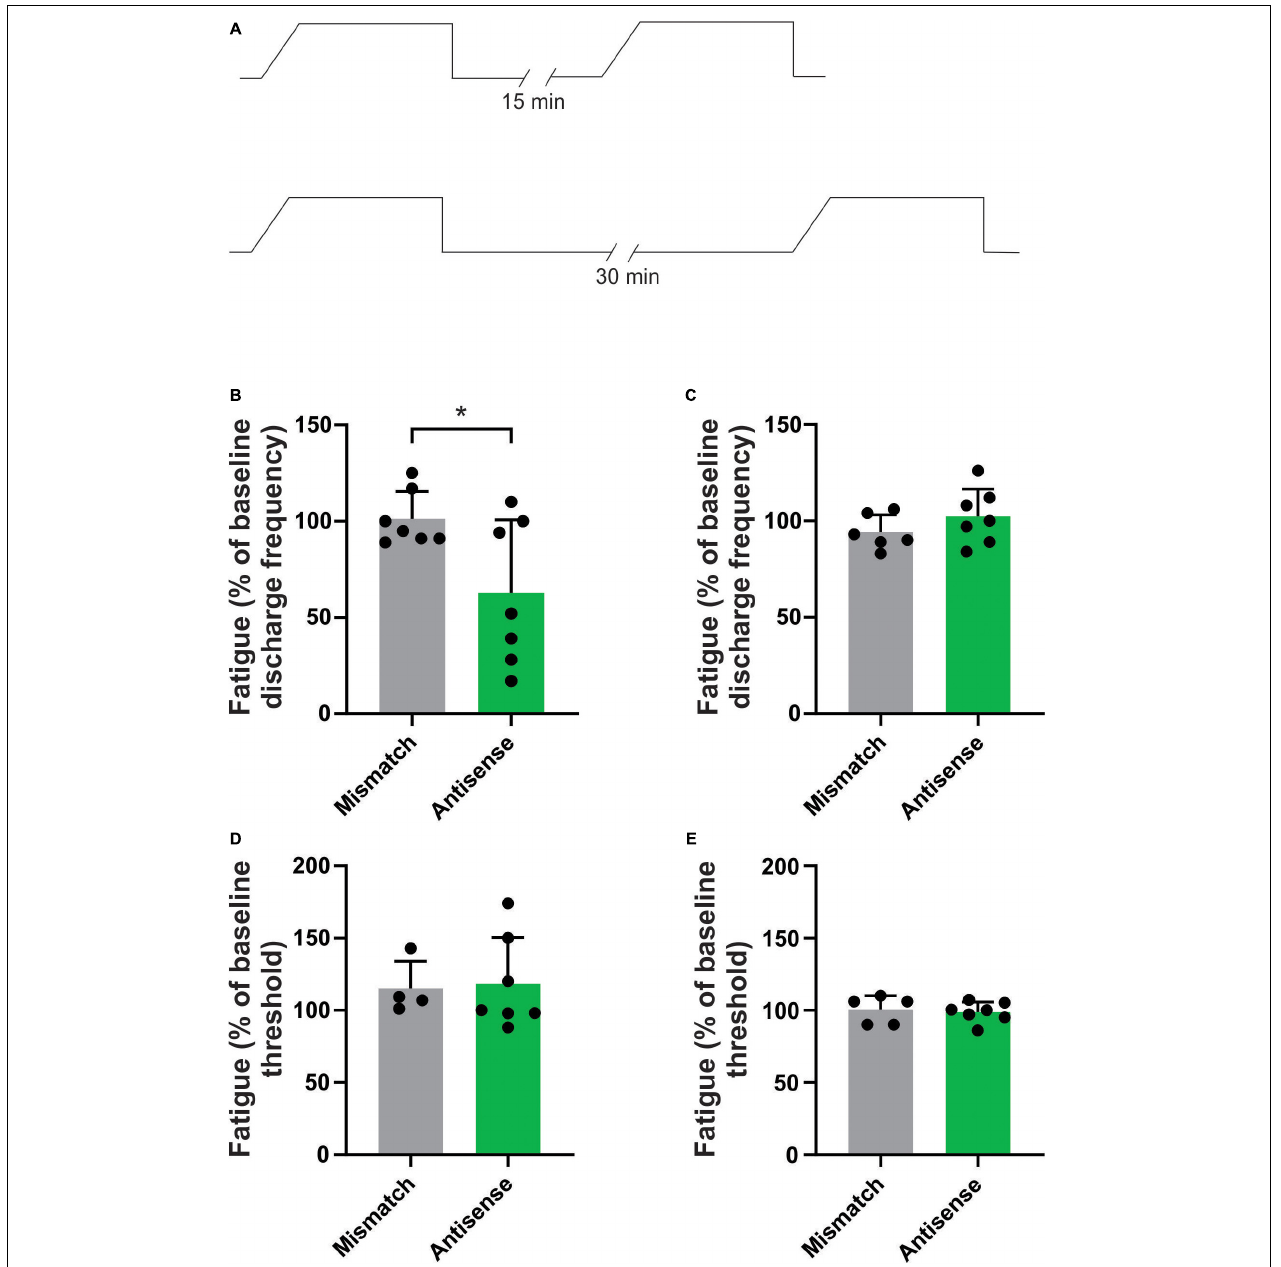
FIGURE 3 | Piezo2 knockdown prolongs stimulus evoked fatigue. (A) Schematic representation of the repetitive stimulation experimental protocol. The response to repetitive stimulation was measured at 15 and 30 min interstimulus intervals (ISIs) and compared between Piezo2 antisense and mismatch control treated animals. (B,C) There was a significant decrease in the discharge frequency of A δ bone afferent neurons recorded from animals treated with Piezo2 antisense, relative to those treated with mismatch control, at 15 min ( B , * P < 0.05, unpaired t -test, n = 7 mismatch/7 antisense, N = 3 mismatch/4 antisense) but not 30 min ( C , P > 0.05, unpaired t -test, n = 6 mismatch/7 antisense, N = 3 mismatch/4 antisense) ISIs. (D,E) There were no differences in the threshold for activation of A δ bone afferent neurons recorded from animals treated with Piezo2 antisense, relative to those treated with mismatch control, at either 15 min ( D , P > 0.05, unpaired t -test, n = 4 mismatch/6 antisense, N = 3 mismatch/4 antisense) or 30 min ( E , P > 0.05, unpaired t -test, n = 5 mismatch/7 antisense, N = 3 mismatch/4 antisense)